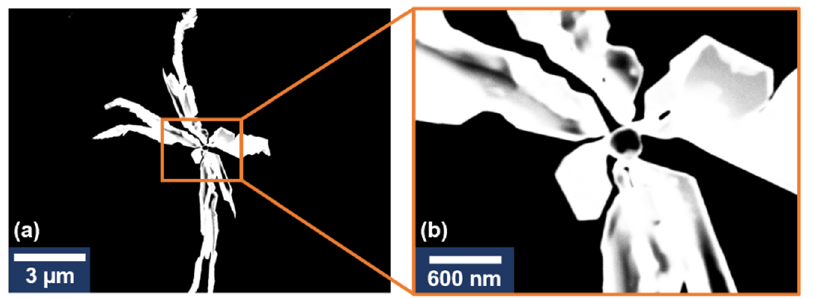
Figure 3. STEM image of an individual silver nanostar ( a ). STEM image of the central zone of the nanostar ( b ).